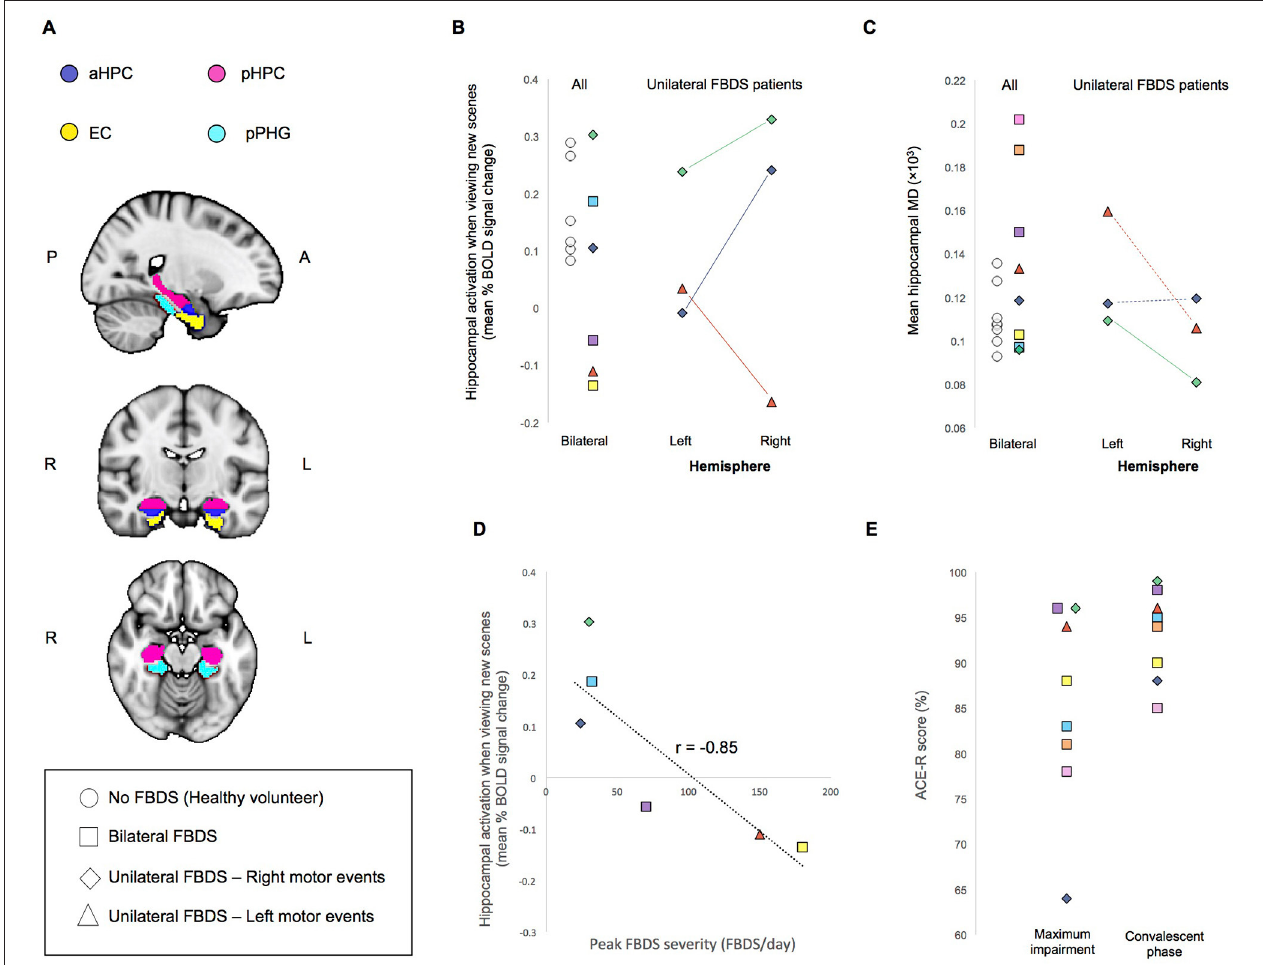
FIGURE 1 | (A) Regions of Interest (ROIs) used for analysis. aHPC, anterior hippocampus; pHPC, posterior hippocampus; EC, entorhinal cortex; pPHG, posterior parahippocampal gyrus. (B) Mean percent BOLD signal difference during the encoding of new scenes verses viewing familiar scenes and (C) Mean hippocampal MD. For individuals who had unilateral FBDS, hemisphere specific measures are additionally plotted. Solid lines indicate between hemisphere differences in the predicted direction (based on clinically observed laterality of FBDS motor events), whereas dashed lines indicate between hemisphere differences were not in the predicted direction. (D) Correlation between peak FBDS severity and mean bilateral percent BOLD signal change in hippocampus during the encoding of new scenes compared to when viewing familiar scenes is plotted. Refer to Table 1 to match symbols of participating FBDS patients with individual demographic and clinical characteristics. (E) Peak ACE-R score at the time of peak impairment during the convalescent phase (day of neuroimaging